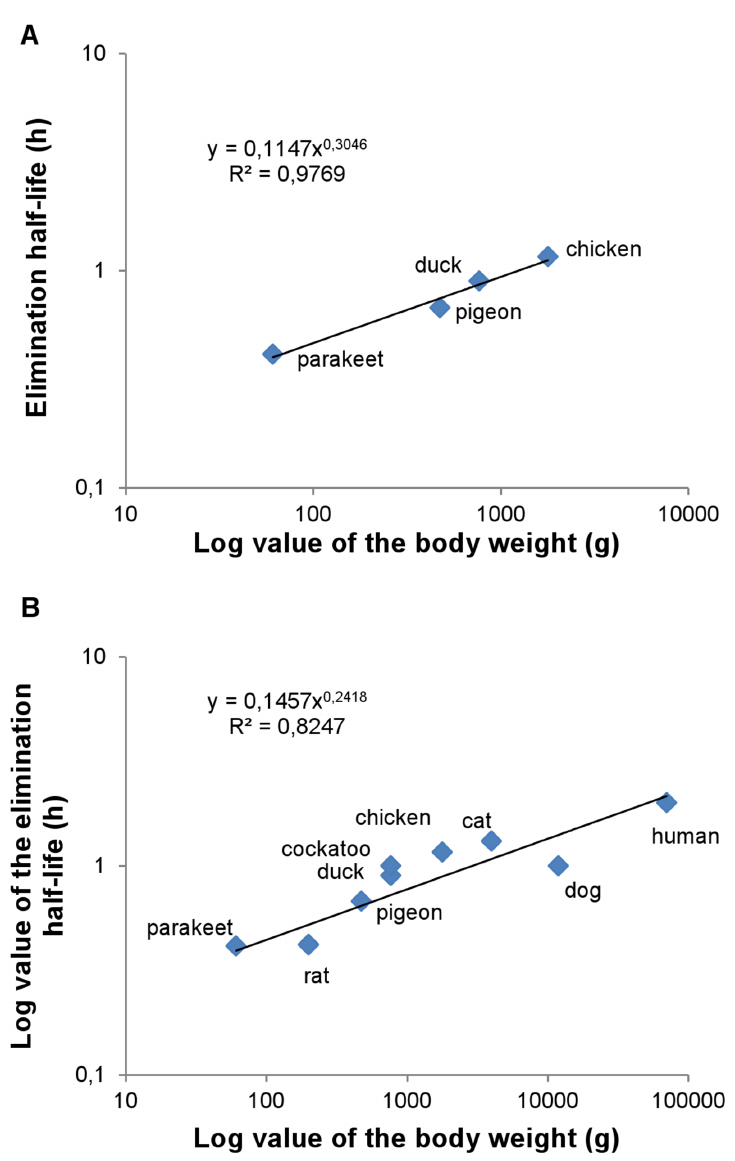
Fig 2. Allometric scaling of the elimination half-life of free carboplatin in different avian species derived from the present study (a) and in all species for which literature data are available (b). Elimination half-life values of rat, cockatoo, cat, dog and human were derived from [13, 22 – 25].